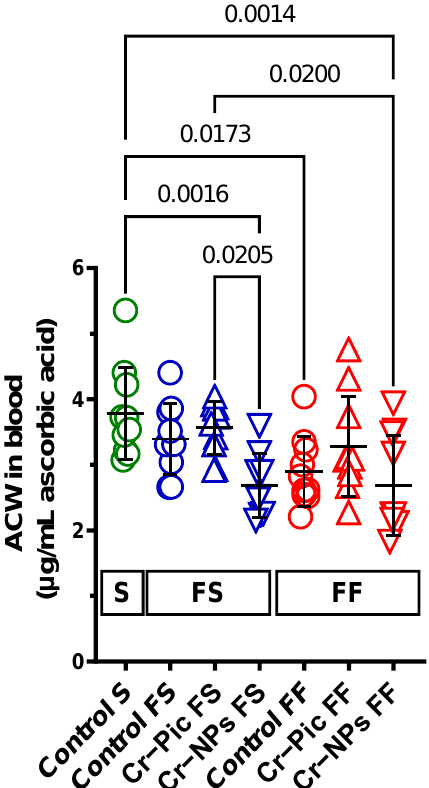
Figure 2. Blood plasma ACW of either chromium (Cr)-supplemented (9 weeks of supplementation) or non-supplemented (Control S, Control FS, and Control FF) rats. 0.3 mg of Cr per kg of body weight as chromium picolinate (Cr–Pic) or chromium nanoparticles (Cr–NPs) were added after the initial 9 weeks of experimental feed without Cr supplementation. Two types of diet were applied: a standard-fat-and-fiber (S) diet and a high-fat–low-fiber (F) diet. Rats at 7 weeks of age were fed with an S diet or an F diet for either 9 weeks or 9 + 9 weeks. The following groups of rats were studied: Control S, the S diet plus the S diet; Control FS, the F diet and the S diet; Cr – Pic FS, the F diet and the Cr – Pic S diet; Cr – NPs FS, the F diet and the Cr – NPs S diet; Control FF, the F diet and the F diet; Cr – Pic FF, the F diet and the Cr – Pic F diet; Cr – NPs FF, the F diet and the Cr – NPs F diet. Values are means ± SD, n = 10, p ≤ 0.05 (two - way ANOVA/Tukey’s multiple comparisons test). ACW is a marker that distinguishes Cr – NPs from Cr – Pic in rats fed with the F diet for 9 weeks. Abbreviations: ACW, antioxidant capacity of water-soluble compounds.